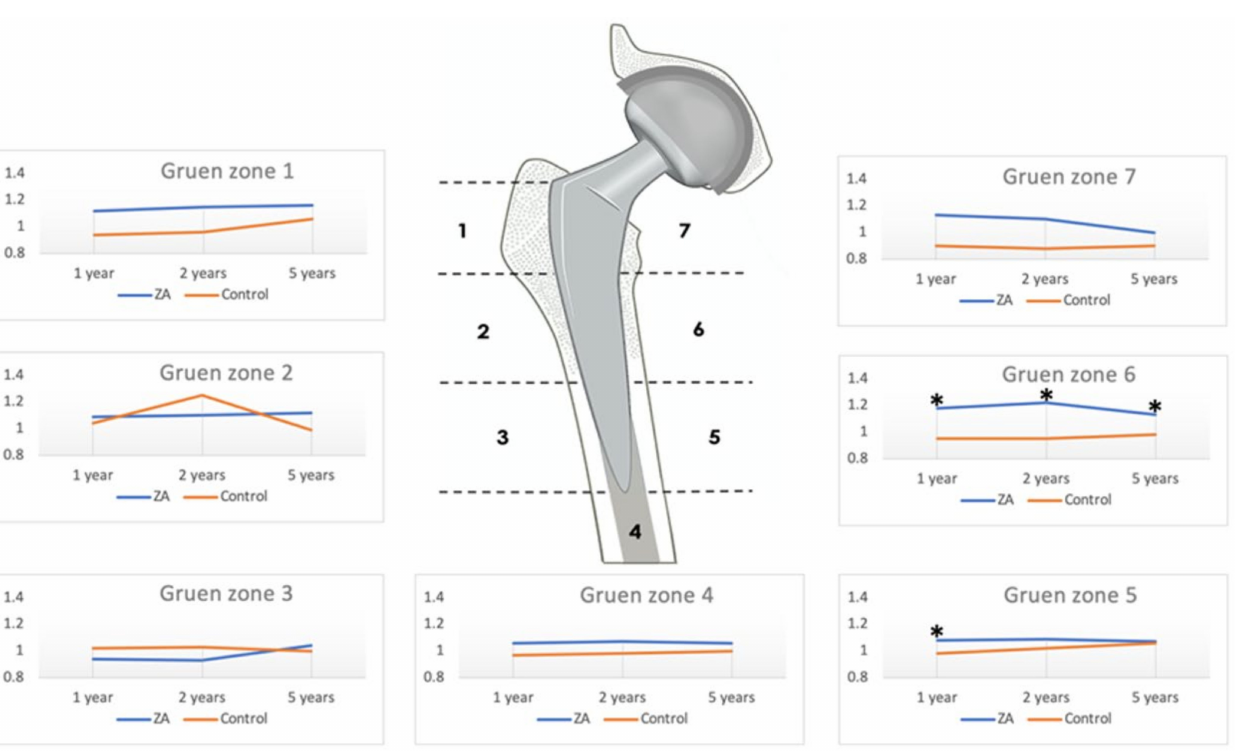
Figure 2. Bone mineral density Change Ratios for zoledronic acid (ZA) and control group in the seven Gruen zones. * p <